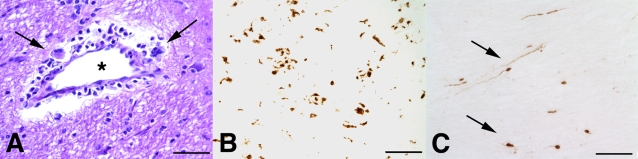
SIV infection induced encephalitis, increased CNS CD68 expression, and axonal accumulation of APP.SIV-infected pig-tailed macaques that developed encephalitis had multifocal perivascular accumulations of infiltrating macrophages and multinucleate giant cells (A, arrows denote giant cells, * denotes blood vessel lumen, hematoxylin and eosin stain, bar = 50 uM), increased CNS CD68 expression reflecting activation of macrophages and microglia in subcortical white matter shown by immunohistochemical staining with an anti-CD68 antibody (B, bar = 50 uM), and accumulation of APP in axons (arrows) in the corpus callosum (C, bar = 100 uM).